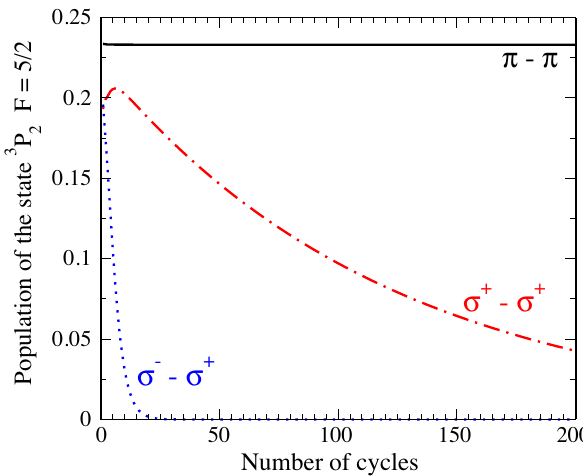
FIG. 7. The relative population of the excited level 2 3 P 2 ∶ F 3 ¼ 5 = 2 of Li þ ions as a function of the number of circulations in the ð t Þ is calculated for the moment when storage ring. N 2 3 P 2 ∶ F ¼ 5 = 2 the ions pass the detection region and for the various polarization states of the applied